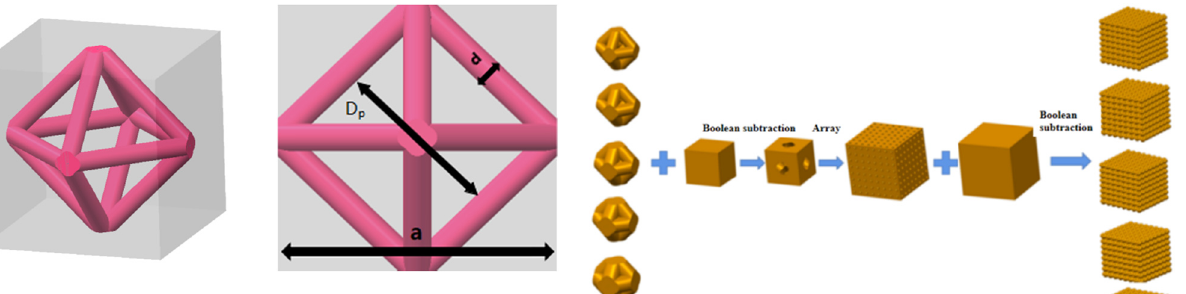
Figure 1: Lattice structure and side length, edge diameter, and aperture of the lattice.